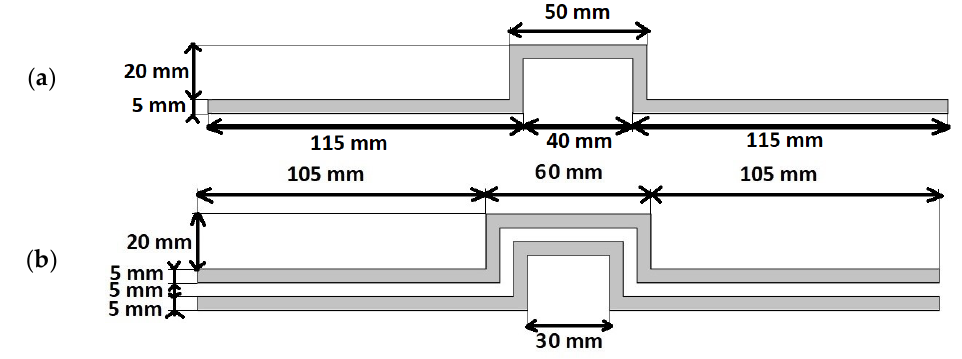
Figure 1. Geometric dimensions of the textile signal line. View from the side of the signal path ( a ), View from the side of the ground paths ( b ).